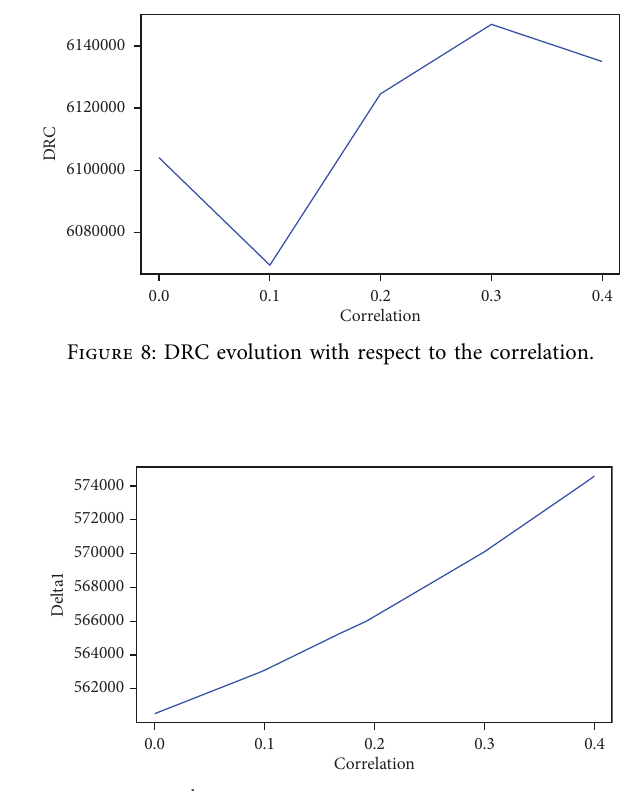
Figure 9: Δ 1 q evolution with respect to the